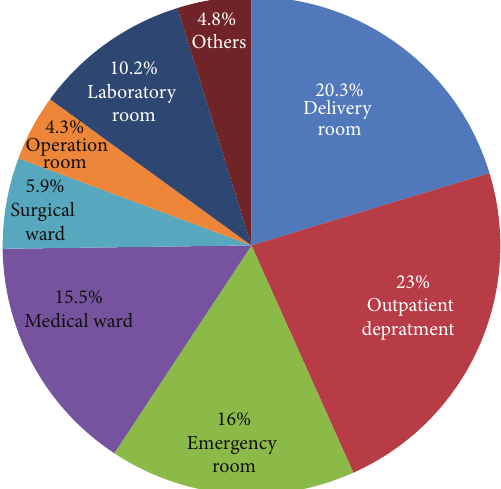
Figure 6: The percentage of healthcare workers in different working unit who had been experiencing needle stick injury, contact with potentially infectious blood and other body fluids, and glove breakage in the past 12 months in selected health institutions, 2014.